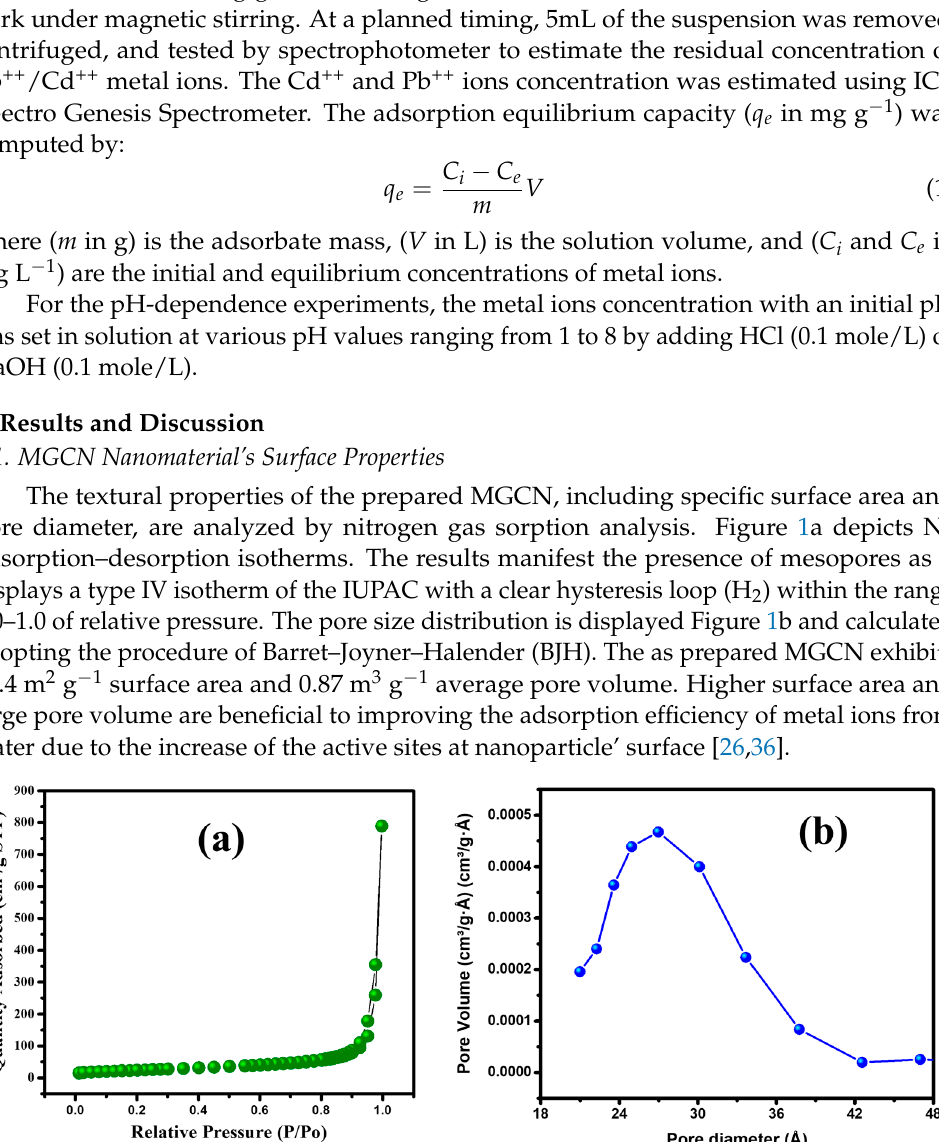
Figure 2. ( a ) Raman spectrum, ( b ) FTIR spectrum, and ( c ) XRD pattern of MGCN sorbent. The bonding and functional groups of MGCN sorbent are determined by the FTIR spectrum recorded in the range 400–4000 cm − 1 , see Figure 2b. The intense band at 810 cm − 1 is relevant to heptazine units’ vibration, which agrees with the literature [31,40]. Moreo- ver, the bands 1414/1486 cm − 1 are assigned to Mg–O–Mg/Mg–O stretching, thereby con- firming the formation of MgO phase. Additionally, the band at 1640 cm − 1 is assigned to MgO. In fact, the vibrational band observed at the wavenumber at 1384 cm − 1 correspond- ing to the C–O–Mg bonding, manifests the existence of an interaction between MgO and g-C 3 N 4 . This result corroborates with the previous study reported in the literature [41]. Additionally, other peaks between 3000–3500 cm − 1 contribute to the aromatic groups’ sym- metric and asymmetric vibrations of O–H and N–H bonds, implying the absorbance of water molecules [31,42]. Based on the results obtained above, the existence of g-C 3 N 4 and the presence of its crystal structure was proven by the similarity of the distinct peaks be- fore and after adding MgO. The crystalline structure of the fabricated MgO/g-C 3 N 4 sorbent is depicted in Figure 2c. The results obviously show the characteristic peaks for g-C 3 N 4 and MgO, indicating that the loading of MgO onto g-C 3 N 4 has been successfully achieved. For g-C 3 N 4 , the strong peak at 27.6° alongside a the small peak at 13.2 ◦ correspond to the (002) and (001) planes, consecutively [43]. The remaining peaks observed in the XRD pattern at 2 θ = 36.8°, 42.7°, 62.12°, 74.6°, and 78.6° are indexed as (111), (200), (220), (311), and (222) reflections, belonging to the cubic structure of MgO phase in agreement with JCPDS card No. 78–0430